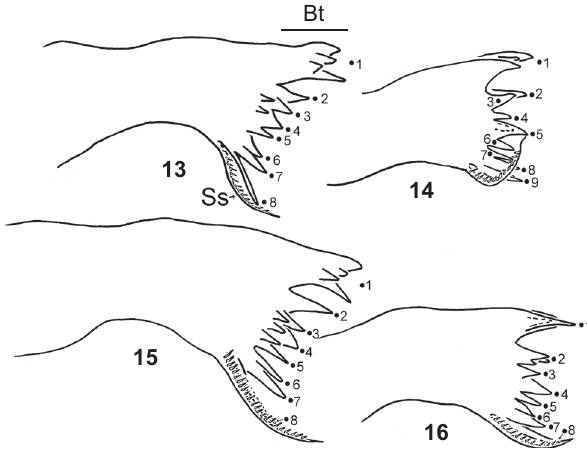
figure: 1.2-1.47:1 (n =